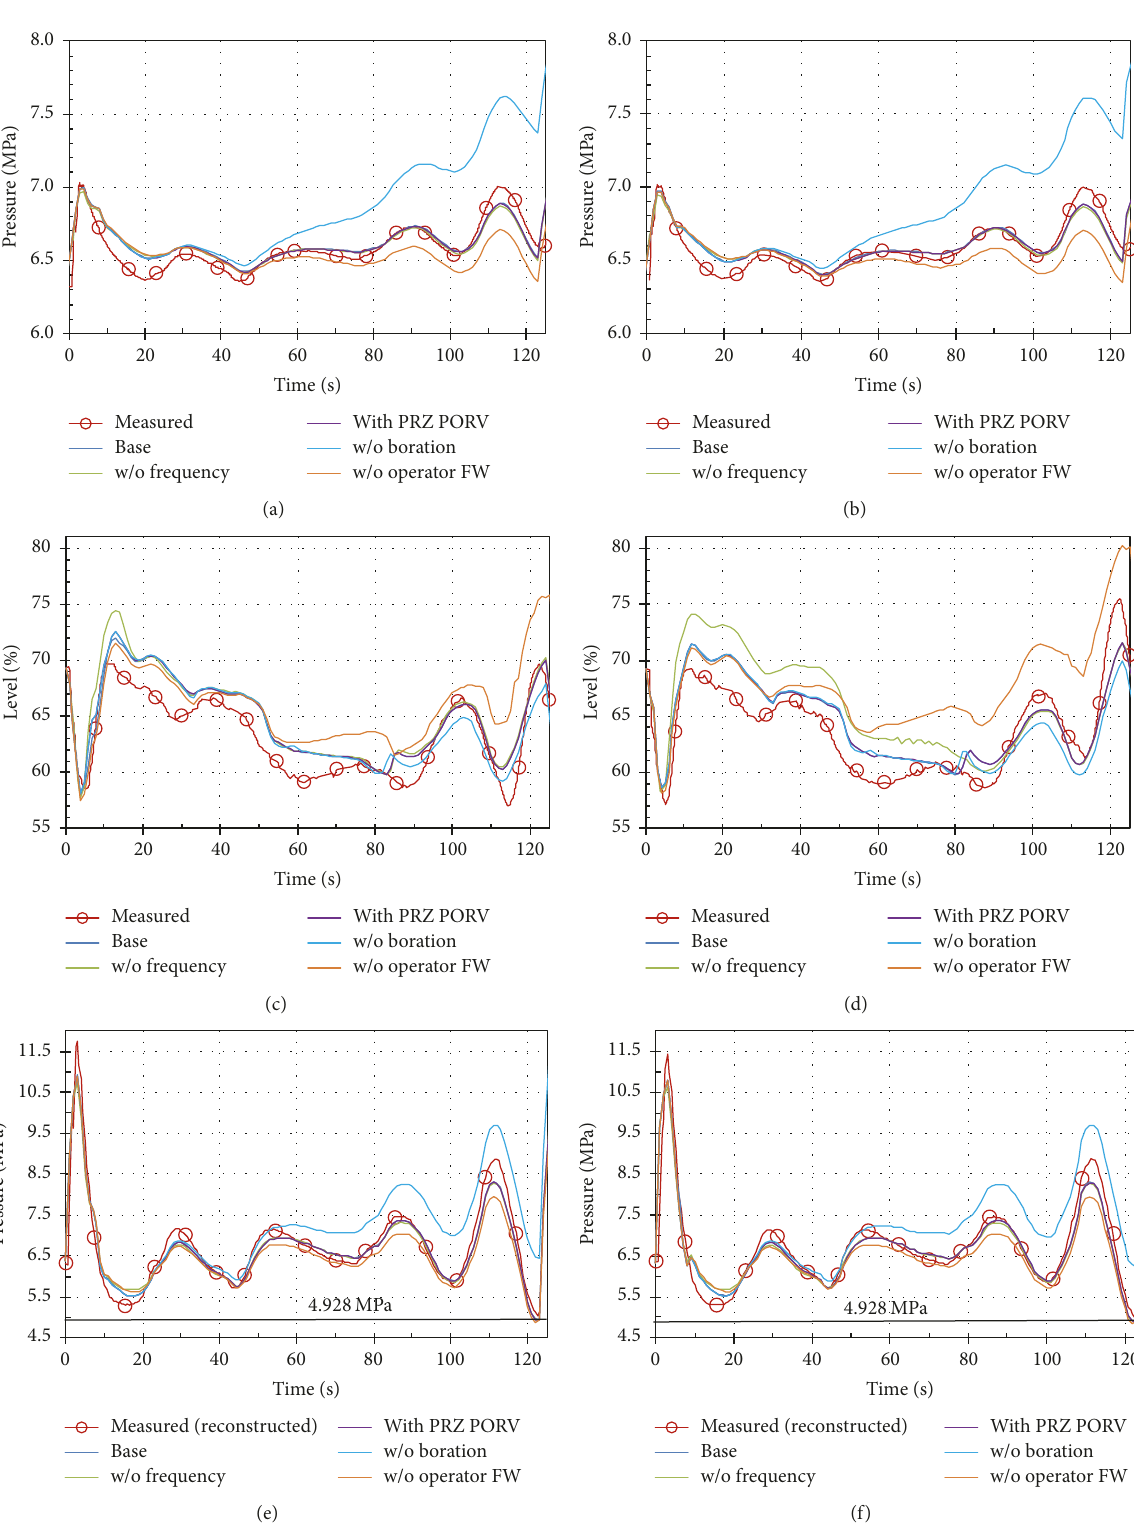
Figure 10: First part: (a) SG number 1 pressure; (b) SG number 2 pressure; (c) SG number 1 narrow range level; (d) SG number 2 narrow range level; (e) LO-2 steam line number 1 pressure signal; (f) LO-2 steam line number 2 pressure